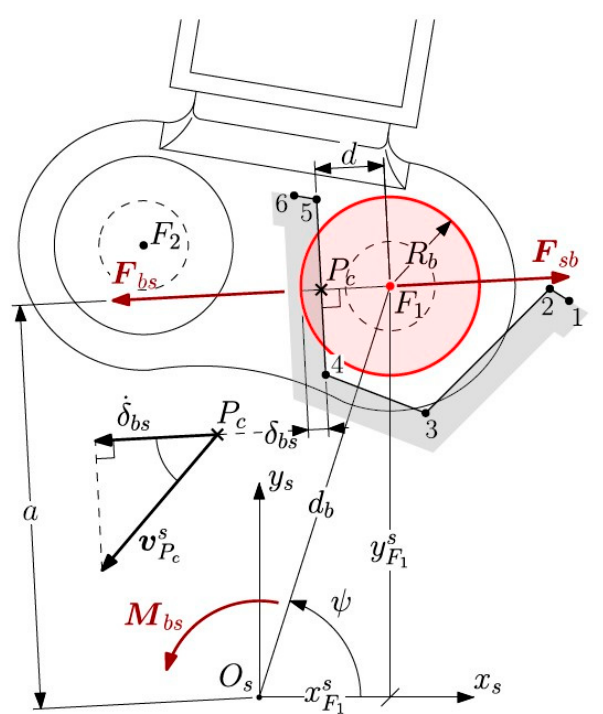
Figure 15. Illustration of the contact between a chain bushing and a sprocket tooth.